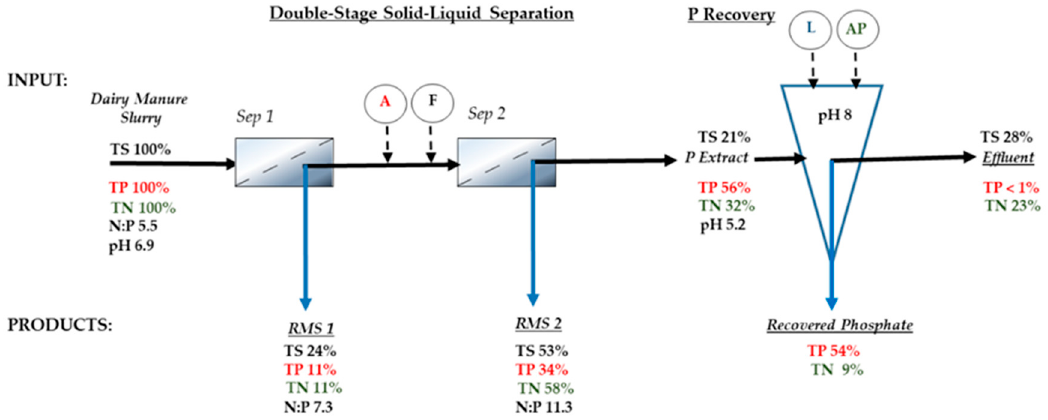
Figure 4. Mass flow of total solids (TS), phosphorus (TP), and nitrogen (TN) through the Quick Wash process integrated with the double stage solid-liquid separation (Sep 1 = 12.7-mm screen, Sep 2 = 0.25 mm screen). Chemical inputs: A = acid; F = flocculant; L = liquid lime; AP = anionic polymer. Data are for Treatment 3 from Figure 3, and Tables 2 and 3. RMS = recovered manure solids.